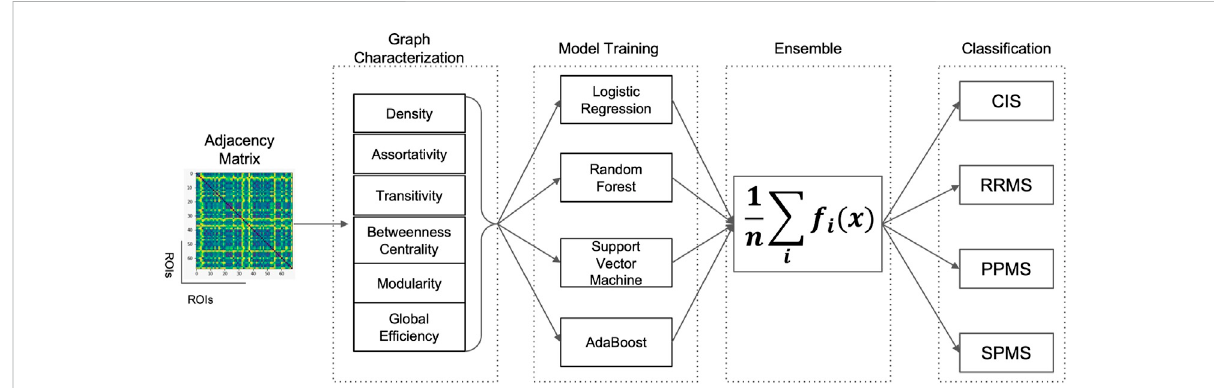
FIGURE 3 Schematic representation of the Machine Learning pipeline implemented for the classi fi cation of MS clinical pro fi les. Starting from the adjacency matrix representation of the brain connectome for a patient, six global graph metrics (Betweenness Centrality (BC), Assortativity ( r ), Transitivity (T), Ef fi ciency ( E g ), Modularity (Q) and Density (D) were calculated and used as input to the four Machine Learning models (Logistic Regression, Random Forest, Support Vector Machine and AdaBoost) independently trained. The four models were then combined in a fi nal ensemble model by majority voting and then used for binary classi fi